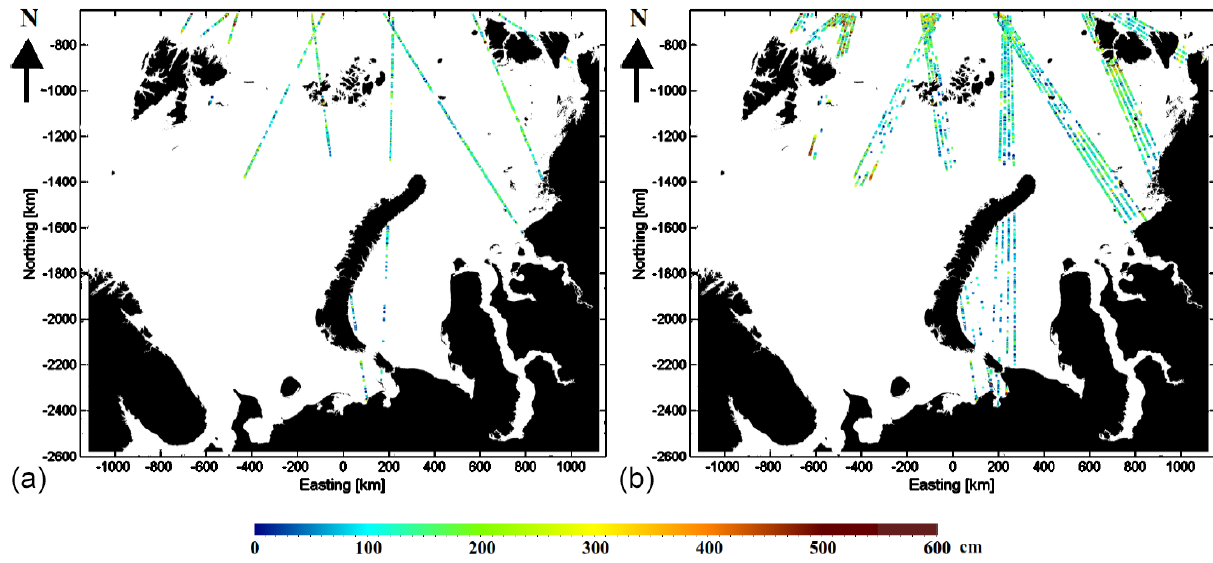
Figure 1. CryoSat-2 sea ice thickness measurements during 1d (a) and 1 week (b) before 21 February 2017.